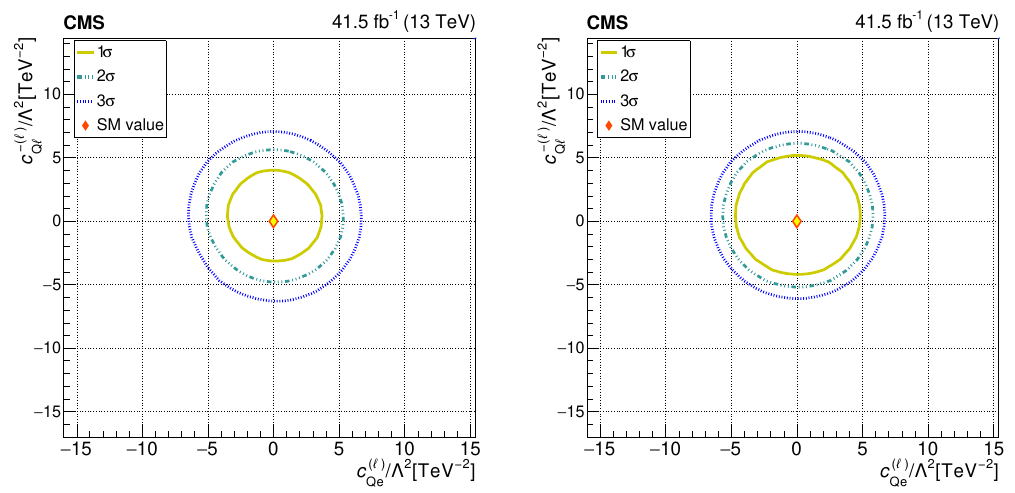
and c ( ‘ ) with Q e Q‘